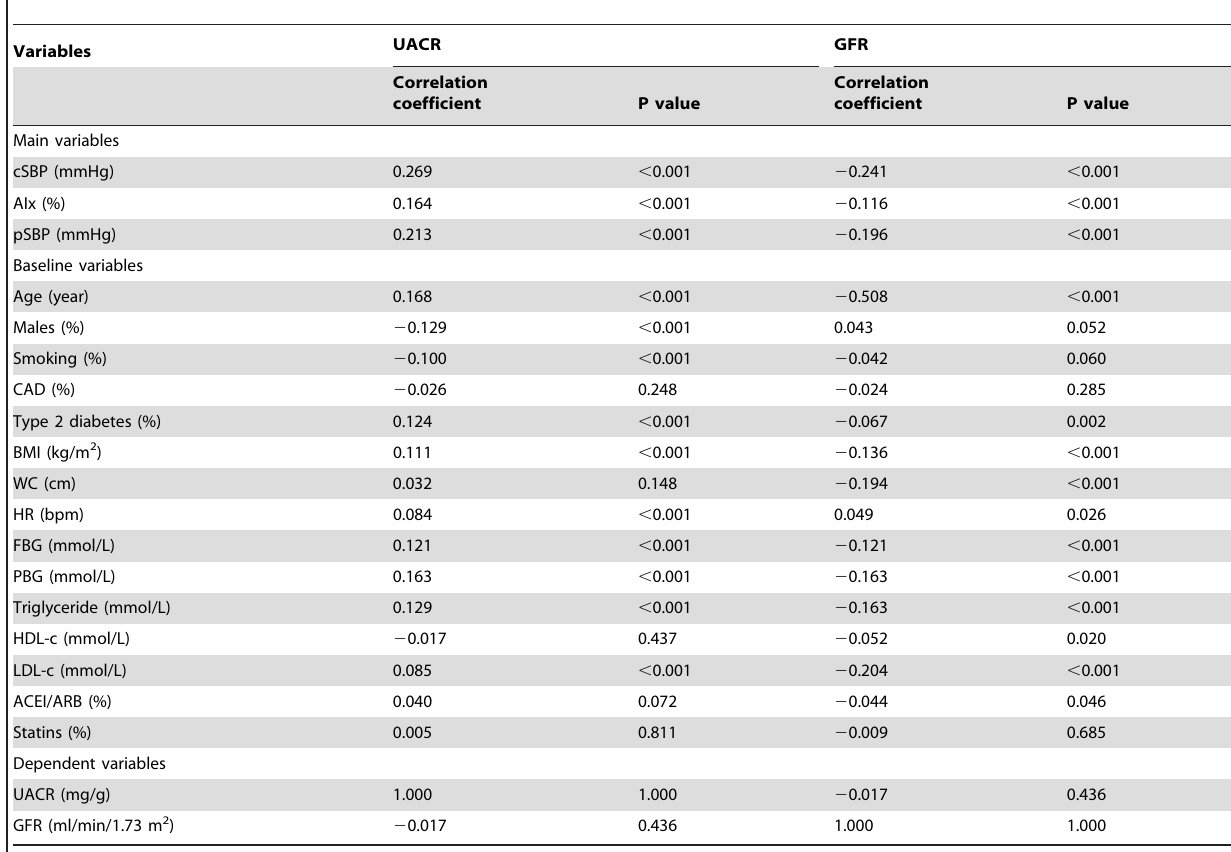
Table 3. Bivariate correlation of UACR and GFR in the whole cohort.